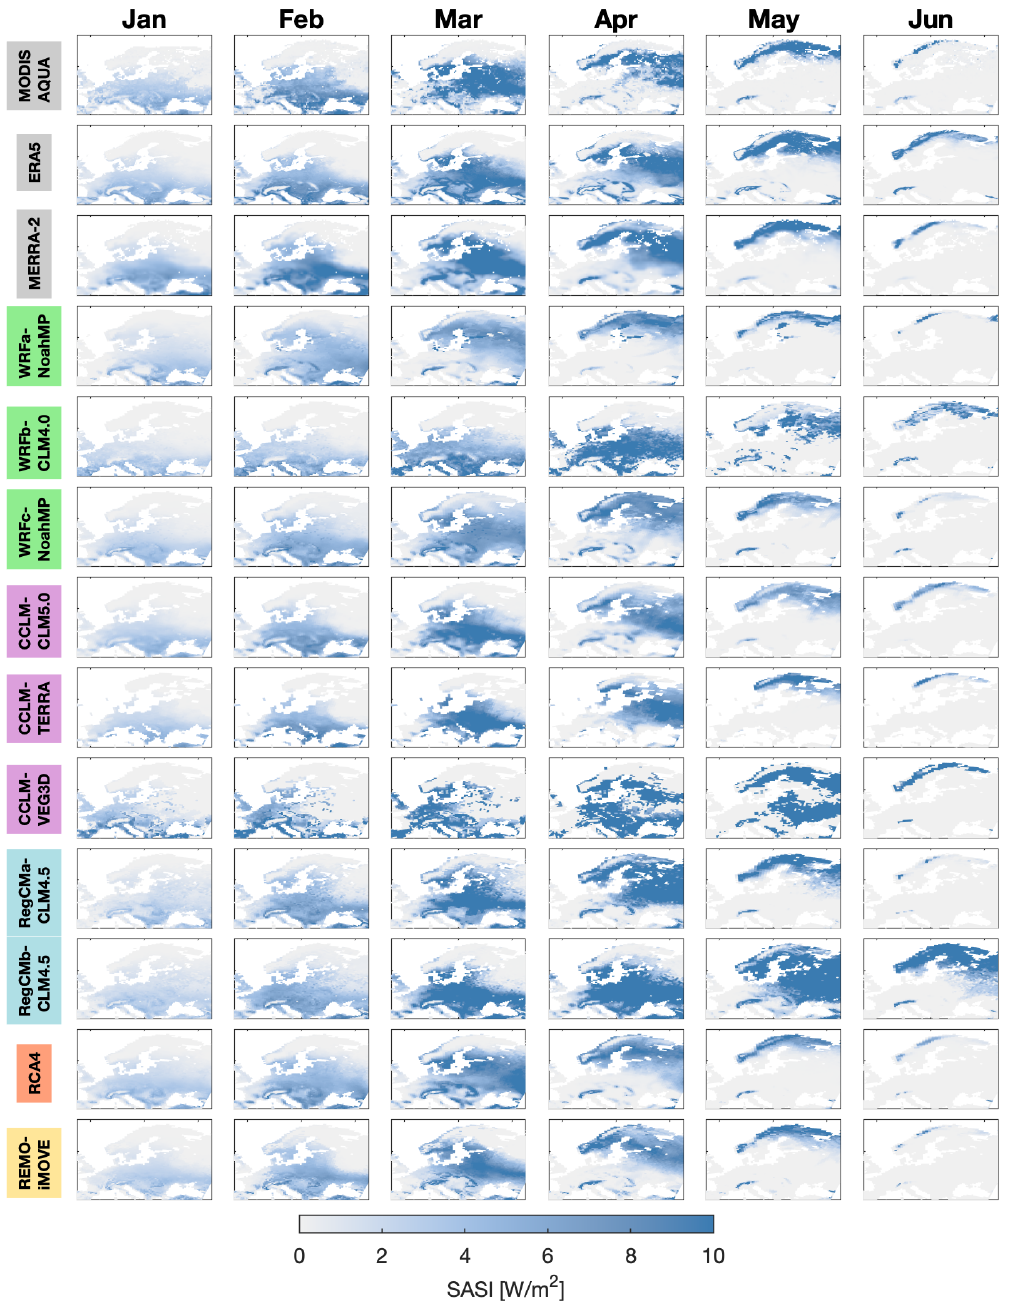
Figure 3. Spatial maps of SASI (Wm − 2 ) for satellite observations of MODIS-AQUA, the reanalysis of ERA5-Land and the 10 RCMs from the EVAL experiment of LUCAS from January to June, averaged over the time period